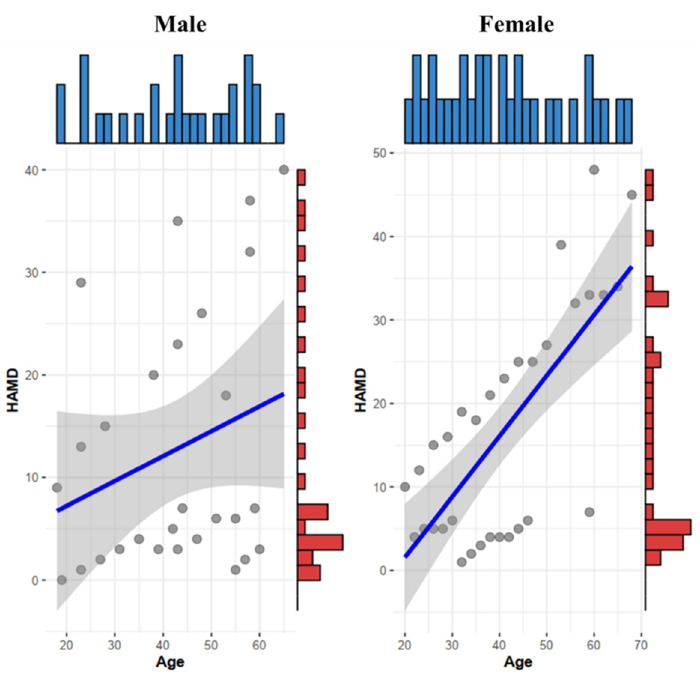
Figure 2. Male and female age and HAMD-24 score distribution chart.